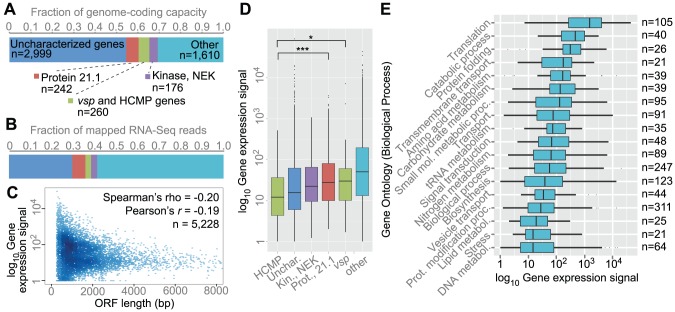
Transcription levels at various classes of protein-coding features.(A) Fraction of the genome occupied by various protein-coding features (WB isolate): uncharacterized genes (hypothetical genes), Protein 21.1, cysteine-rich membrane protein genes (vsp and HCMP genes), Kinase NEK and other genes. The x-axis shows the total protein-coding capacity of the genome for each group of genes. (B) Fraction of the RNA-seq data that mapped on categories in (A). (C) Smooth scatter plot of the relationship between gene expression and ORF length. The x- and y-axes show log10-scaled FPKM and ORF length (bp). ORFs longer than 8000 bp were not plotted (n = 71). Transition towards more intense blue means higher plotting density. (D) Box plots of gene expression of different categories of genes. Black dots represent outliers. One-way ANOVA concluded a significant difference between the groups (p<2.2e-16). The Protein 21.1/HCMP pairwise comparison was significant at p = 0.0008972 and vsp/HCMP was significant at p = 0.04642 (Tukey's HSD test). The groups ‘uncharacterized’ and ‘others’ were ignored in the pairwise statistics. (E) Box plots of genes grouped according to Gene Ontology (GO). Genes were categorized into broader groups by Biological Process using the generic slimmed Gene Ontology. Black dots represent outliers. Numbers to the right indicate how many genes were in the category. Groups are sorted after median expression. The following Gene Ontology categories are shown (GO): 0006412, 0009056, 0006457, 0055085, 0006520, 0005975, 0044281, 0006810, 0006399, 0007165, 0034641, 0008150, 0009058, 0016192, 0006464, 0006629, 0006950, 0006259.